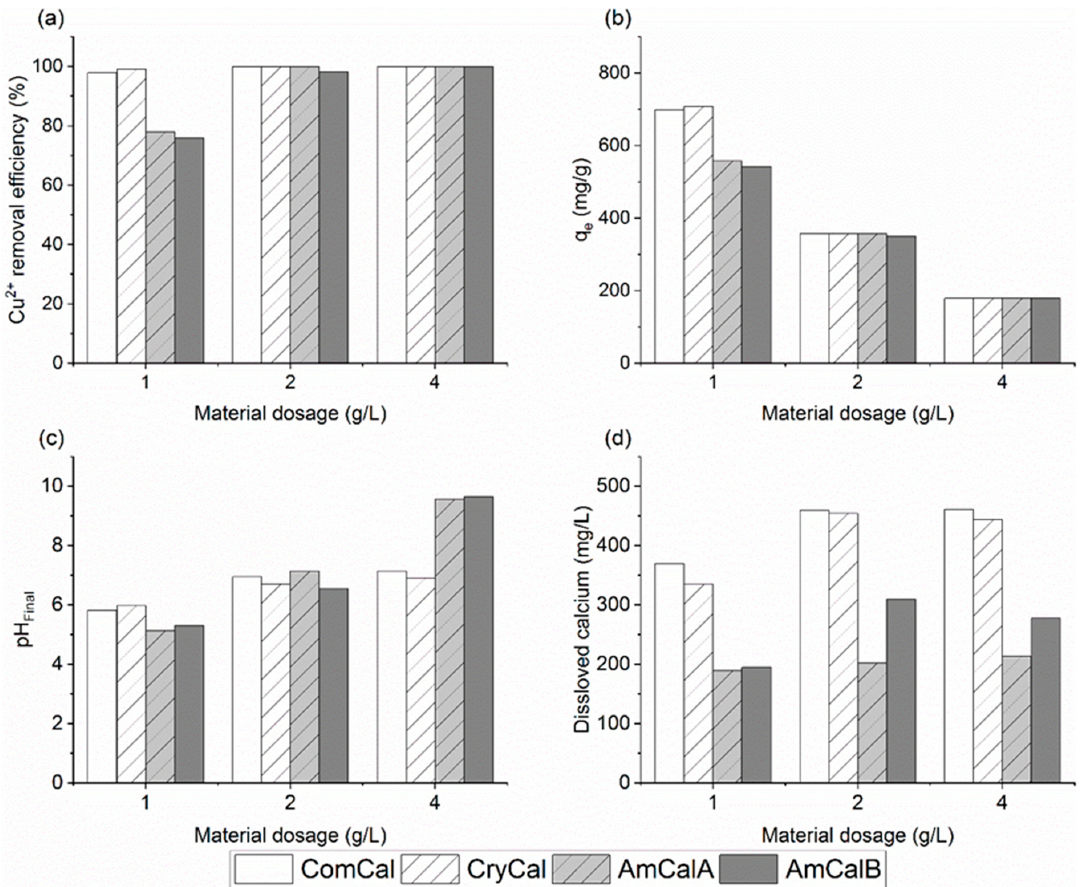
Figure 3. Comparison of Cu 2+ removal ability by various calcium carbonates: ( a ) removal efficiency; ( b ) removal capacity; ( c ) final solution pH, and ( d ) dissolved calcium.